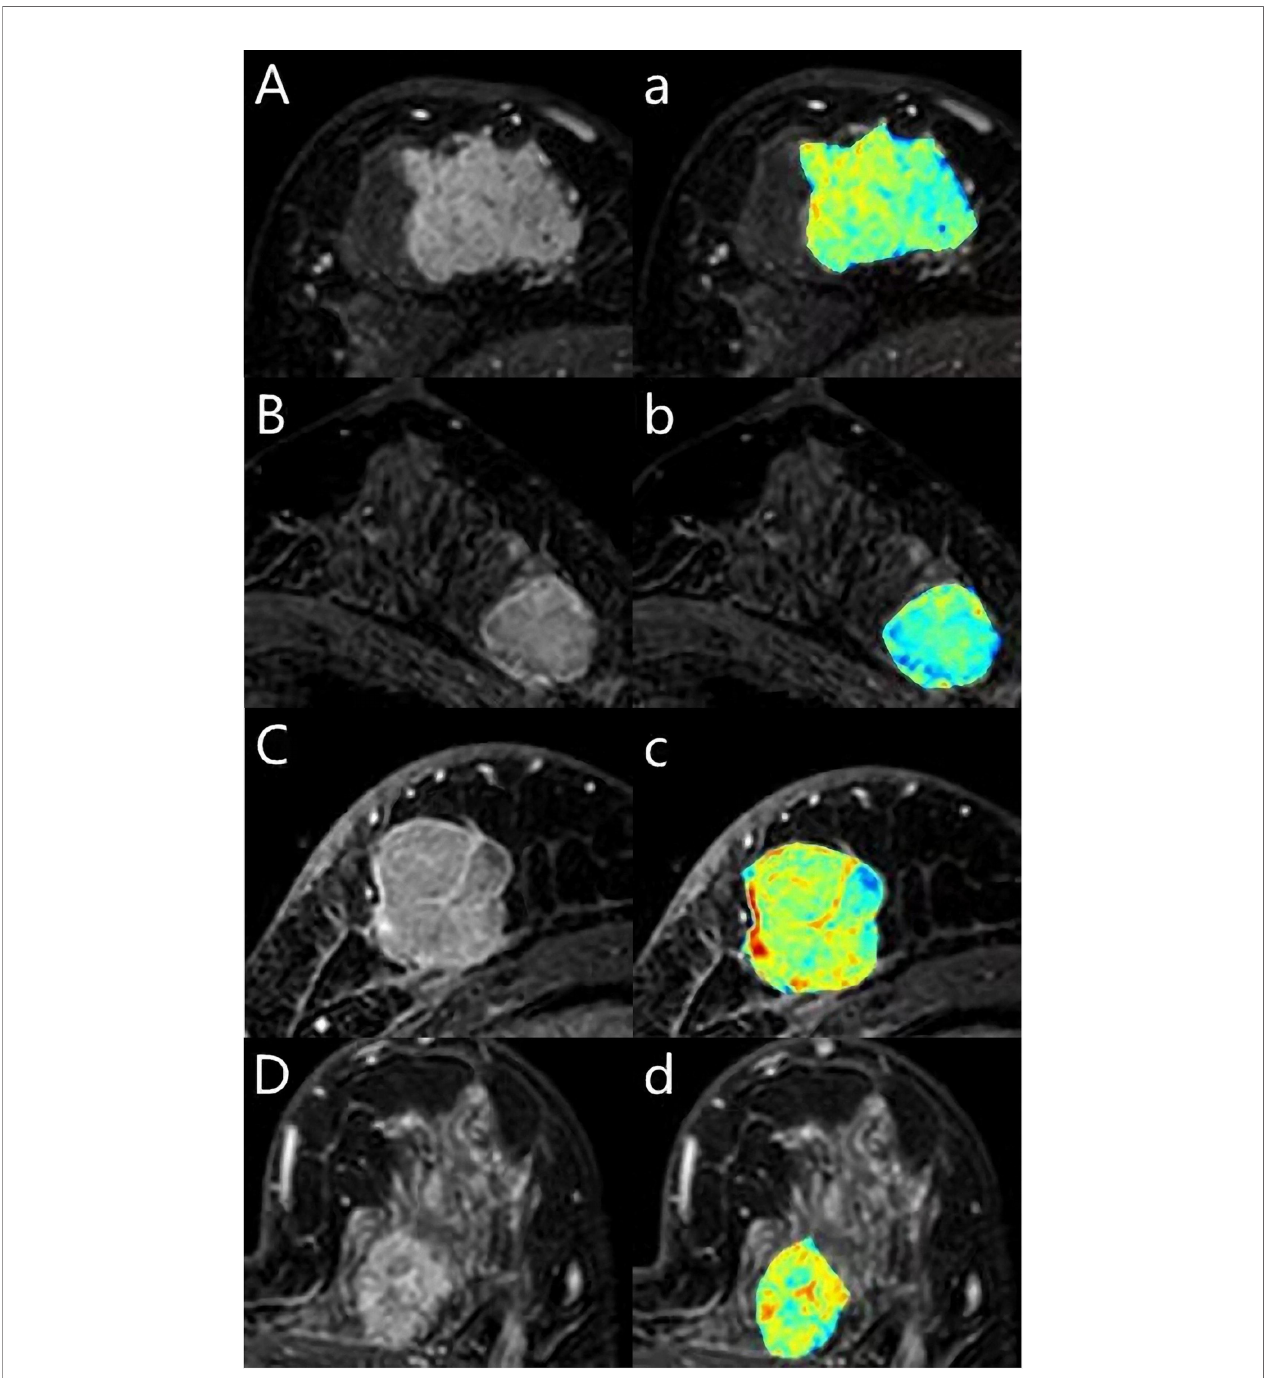
FIGURE 3 | A 62-year-old woman with Luminal A breast cancer (A, a) , a 55-year-old woman with Luminal B breast cancer (B, b) , a 59-year-old woman with triple- negative breast cancer (C, c) , a 43-year-old woman with human epidermal growth factor receptor 2 (HER2) breast cancer (D, d) . The fi rst DCE sequence (ABCD) and the texture map with colors (abcd) were